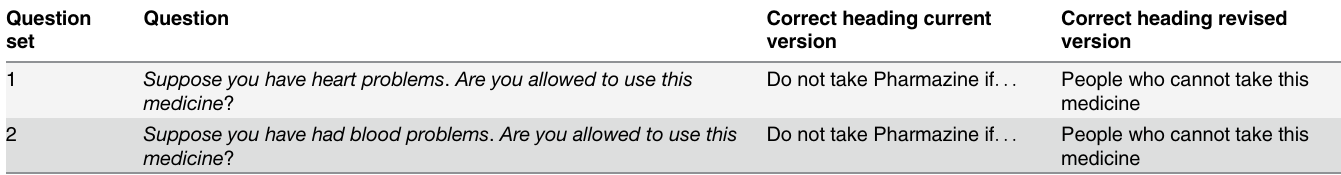
Table 3. A pair of scenario questions presented in the two different question sets relating to the same topic. Question set